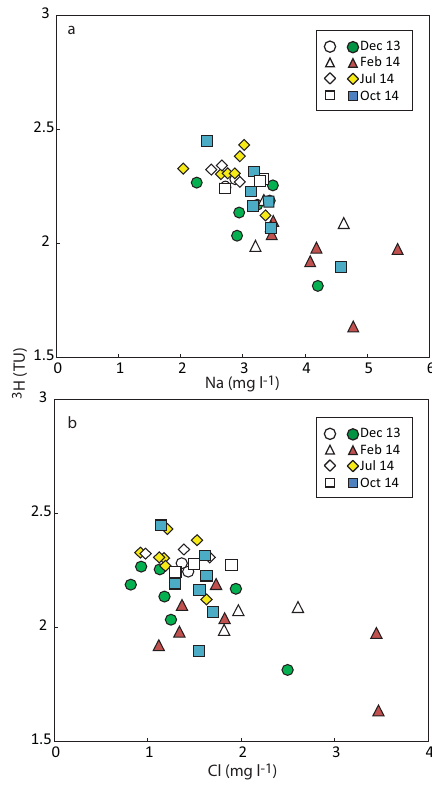
Figure 7. 3 H activities vs. Na (a) and Cl (b) concentrations for the main Ovens River (open symbols) and its headwater tributaries (closed symbols) in the four sampling rounds. Data from Table